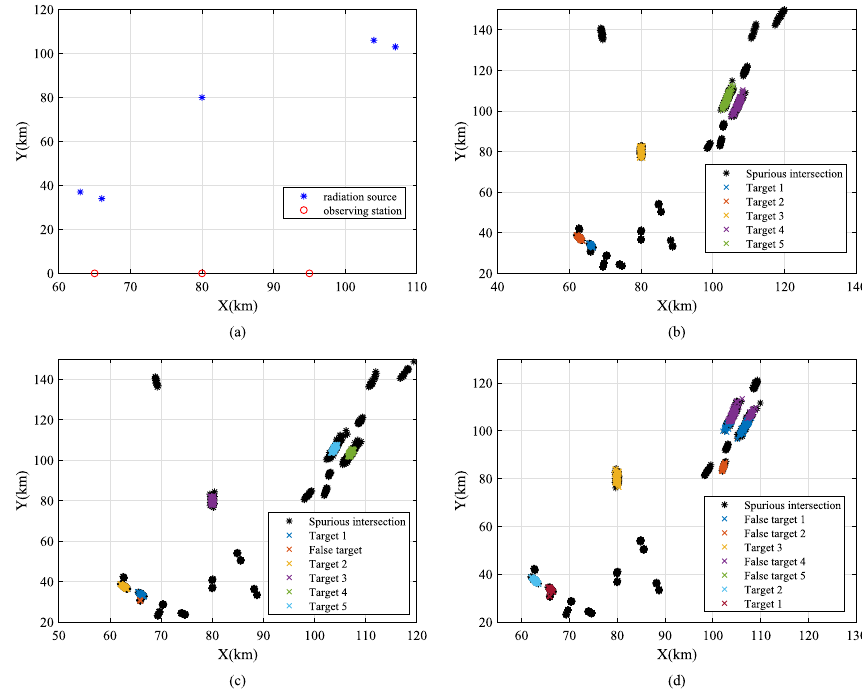
Fig. 8 a Distribution of observation stations and radiation sources; b clustering results of K-M-DBSCAN; c clustering results of DBSCAN; d clustering results of